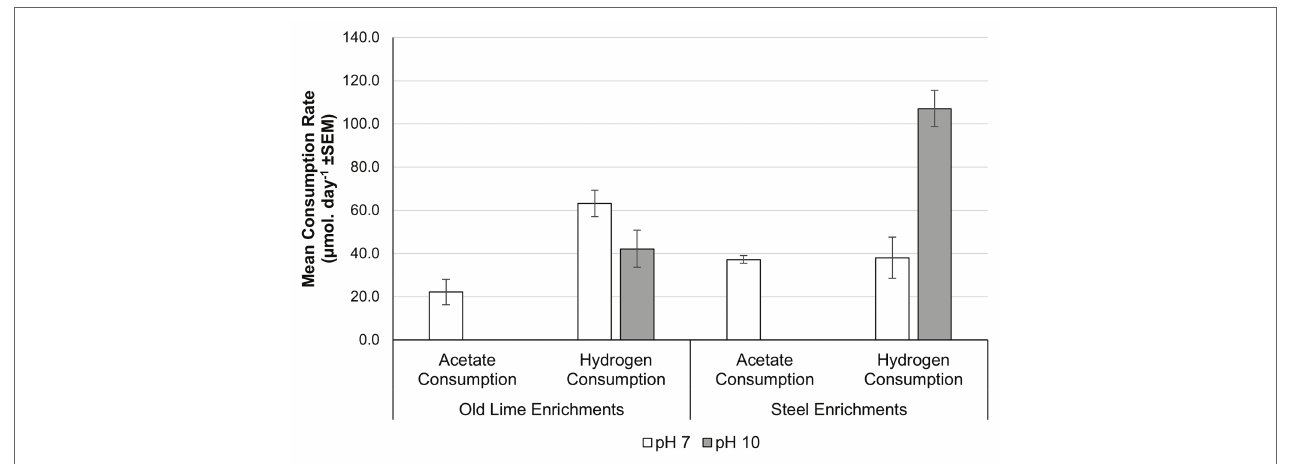
FIGURE 5 | Acetate and hydrogen consumption from microcosms prepared using Old Lime and Steel site sediments as an enrichment inoculum. The pattern observed in the Old Lime ( n = 10) and Steel ( n = 8) sediments mirrored that seen with the New Lime and Control sediments with acetoclastic methanogenesis absent at alkaline pH (“ n ” denotes the number of replicates